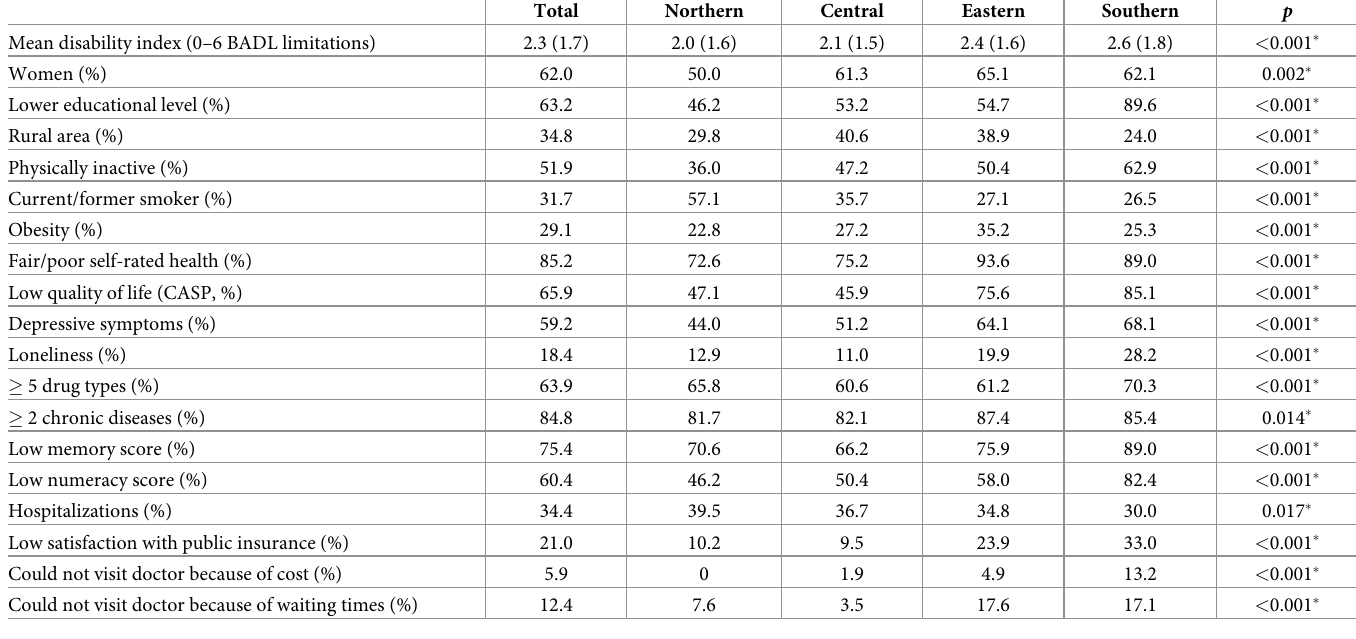
Table 3. Descriptive (frequencies or mean, and standard deviation) and bivariate (Chi-square and ANOVA tests) analysis of disabled older adults in Europe aged 75–84 (n = 2,594), according to European regions and independent variables in 2015.